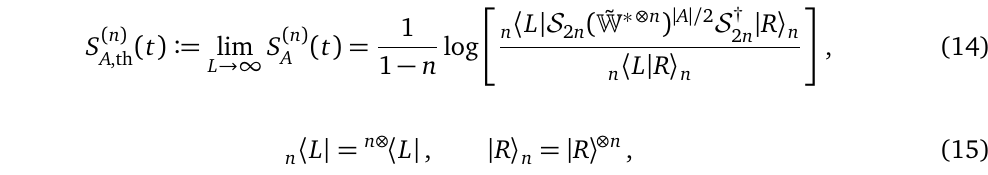
(cid:2) ρ ( t ) 3 (cid:3) in the folded picture. The portions A † and in 2 n S 2 n S